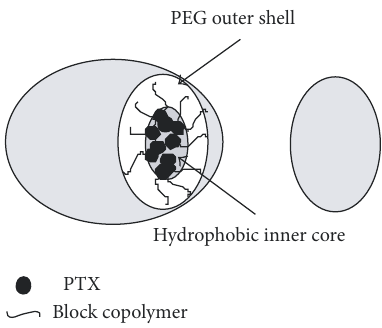
Figure 7: Schematic structure of NK105 (the is figure based on